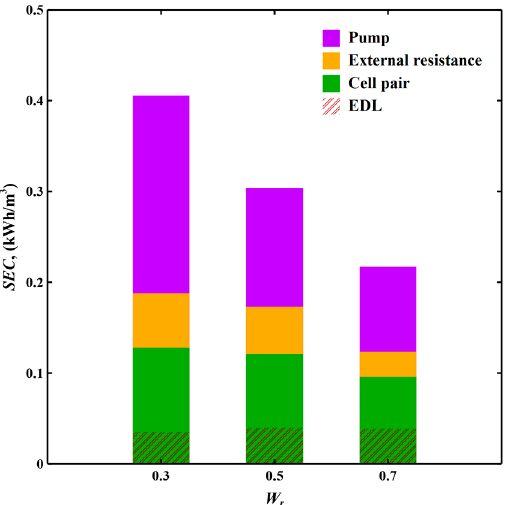
Figure 4. Specific energy consumption (SEC) with the contribution of each component including pump, external resistance and cell pair and the energy stored in electric double layer (EDL) with varying water recovery under quasi-steady state in cut-off constant voltage (CV) mode MCDI for partially softening industrial cooling tower blowdown water. Flow rate is 0.35 L/hr. Applied voltage is 0.4 V.